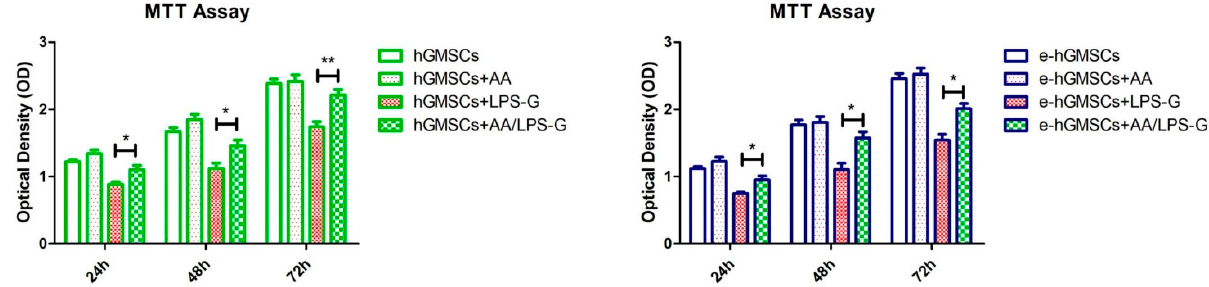
Figure 3. Effects of Lipopolysaccharide from Porphyromonas gingivalis (LPS-G) and ascorbic acid (AA) on the cell metabolic activity of hGMSCs and e-hGMSCs. Cell growth curve of hGMSCs and e-hGMSCs detected by absorbance at 490 nm showed the different cell metabolic activity of cells under treatment with AA, LPS-G and LPS-G + AA. * p > 0.05; ** p < 0.01.